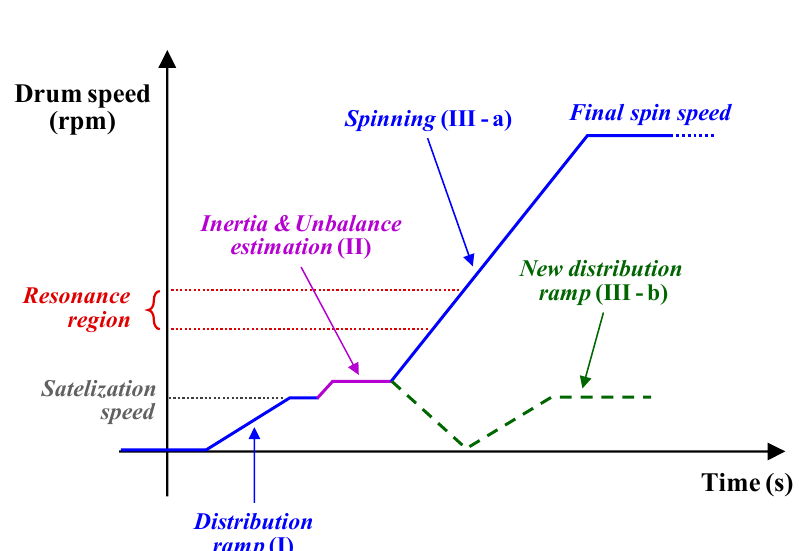
Figure 11. Profile of the drum speed for the proposed method.